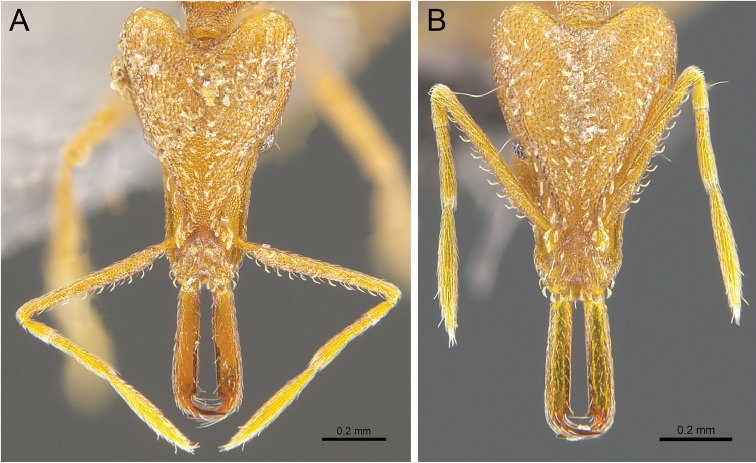
Strumigenysfeae/formosensisA worker (ANTWEB1017082) full-face view B worker (RHL01266) full-face view.